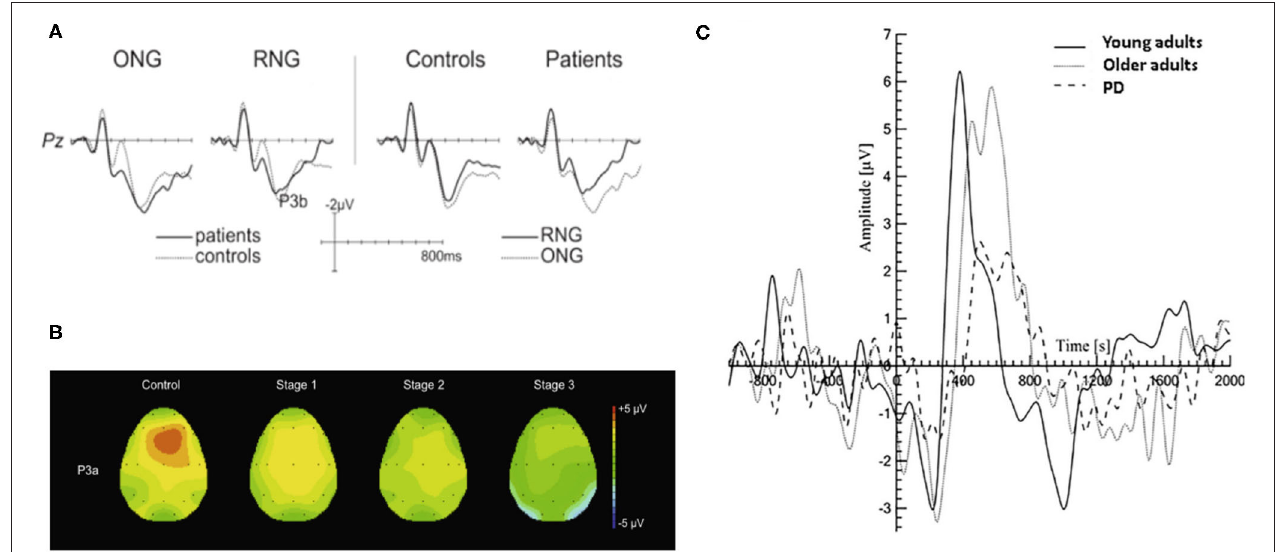
FIGURE 3 | Typical P300 changes in PD patients. (A) A more pronounced reduction in P3b amplitude during the RNG task was observed than that with ONG task (Muente et al., 2015). (B) Topographic maps of P3a in HC group and PD patients in three H&Y stages (stage 1, 2, 3) during an auditory oddball paradigm. The P3a showed a frontocentral distribution and its amplitude was negatively associated with the severity of PD ( Solis-Vivanco et al., 2015). (C) The P300 amplitude is significantly smaller in PD patients (dash line) compared to those in young and older adults (solid black line and gray line, respectively) during walking ( Maidan et al., 2019). HC, healthy control; H&Y, Hoehn and Yahr scale; RNG, random number generation; ONG, ordered number generation. (Image sources were adapted with granted copyright permission.) Figure 3A is available at IOS Press through Muente et al.